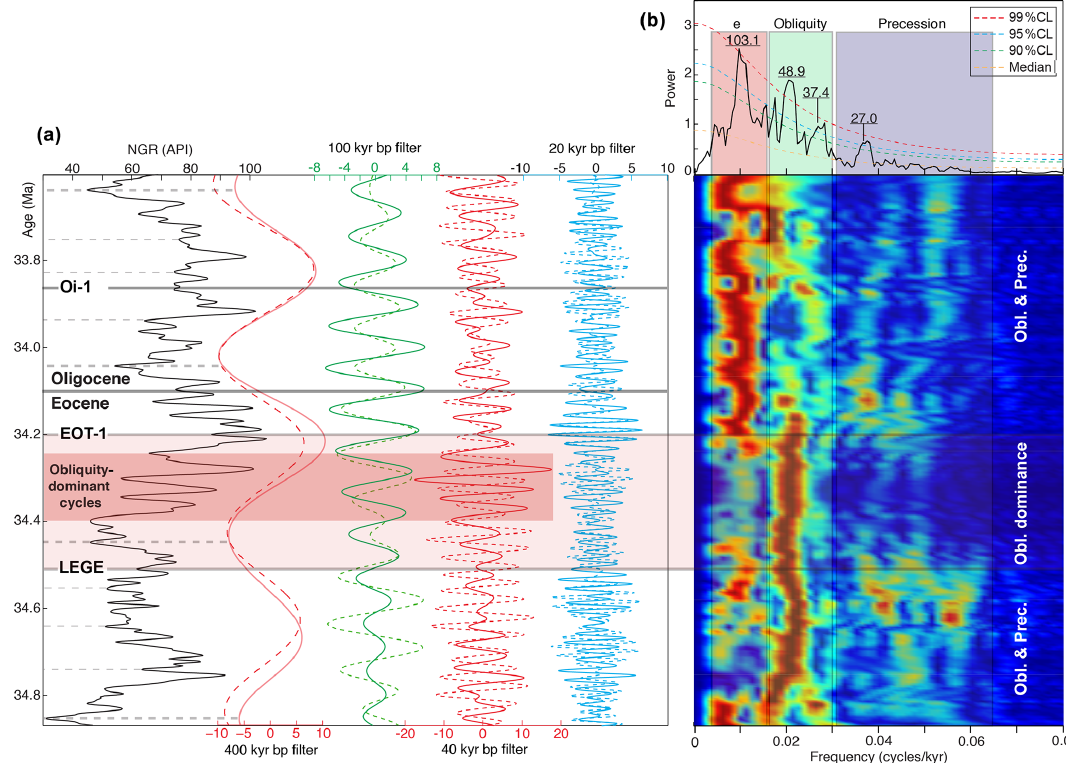
Figure 9. Time-series analysis focused on the Eocene–Oligocene transition (EOT) showing the switch from obliquity to precession eccen- tricity. (a) Tuned NGR time series for the interval from 186 to 232m, anchored at the EOB age of 34.10Ma, with band-pass filtering at the 100 and 400kyr eccentricity, 40kyr obliquity and 20kyr precession bands (solid curves for NGR cycles and dashed curves for La2004 astronomical cycles). Shaded area indicates strong obliquity cycles. (b) Power spectrum and amplitude spectrogram of the detrended (400kyr cycles removed) tuned NGR, with the interpreted astronomical cycles for the 100kyr eccentricity ( e ), obliquity and precession. Periods in the spectrum are in kiloyears. Note the striking switch from obliquity-dominant to precession eccentricity cycles at the Eocene–Oligocene transition event 1 (EOT-1). The interval from the late Eocene glacial event (LEGE) to the EOT-1 records very weak precession, especially at the dark pink-shaded